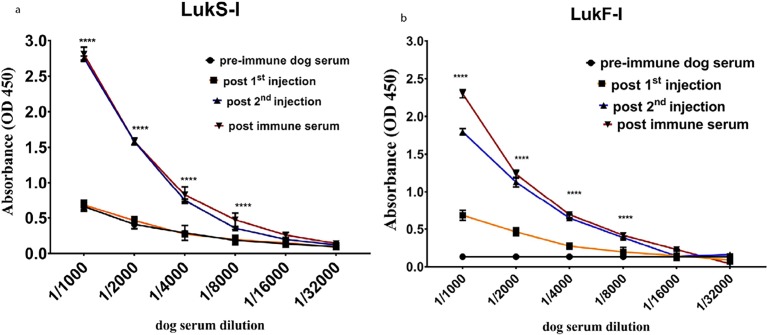
Canine antibody against attenuated LukS-I and LukF-I react with recombinant wild-type LukS-I and LukF-I.Antibodies against S. pseudintermedius wild-type LukS-I and LukF-I were detected using an indirect ELISA. Recombinant S. pseudintermedius LukS-I and LukF-I proteins were coated on ELISA plates, then incubated with two-fold serially diluted serum from dog vaccinated with the same proteins. High reactivity with LukS-I and LukF-I was seen from sera collected two weeks after 3rd injetions of attenuated LukS-I (P <0.0001****) and LukF-I (P <0.0001****) compared to pre-injection sera. The values represent averages from three independent experiments.